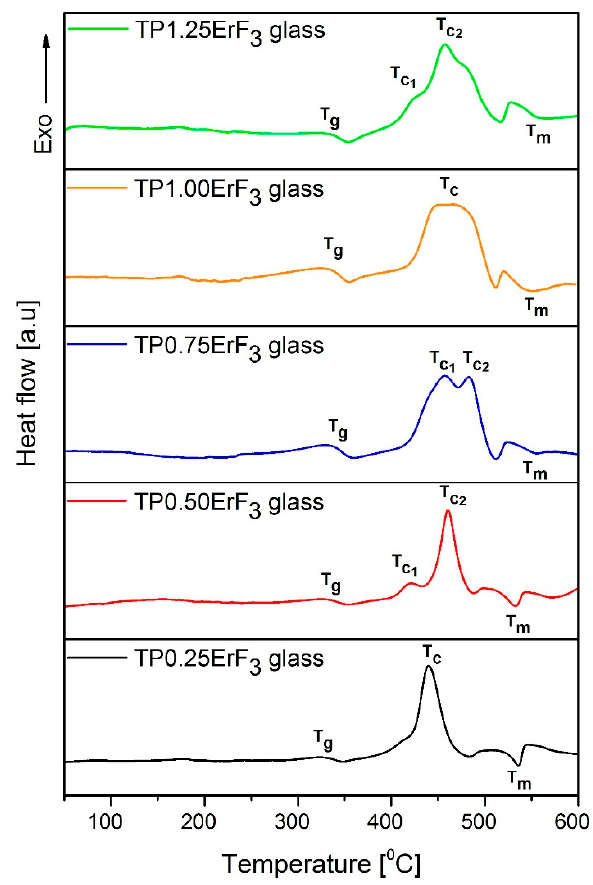
Figure 2. DSC curves of oxyfluoride phospho-tellurite glass doped with ErF 3 . Table 1. Glass transition (T g ), crystallization (T c ), melting (T m ) temperatures, and thermal stability ( Δ T) of erbium-doped phospho-tellurite glass.